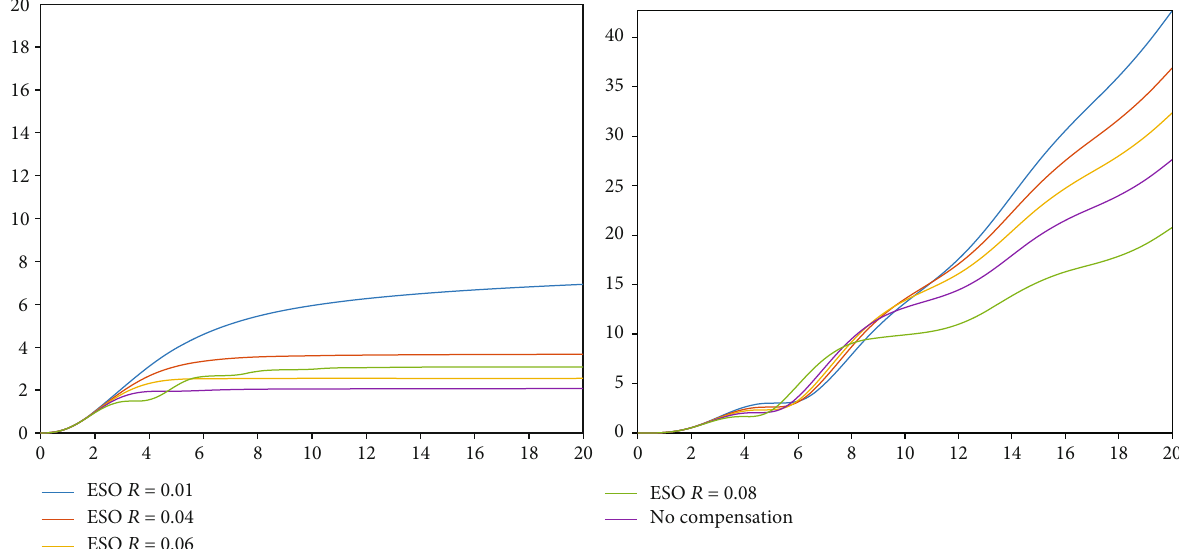
Figure 21: E ff ect of target random maneuver on dimensionless miss distance under step and wave disturbance.